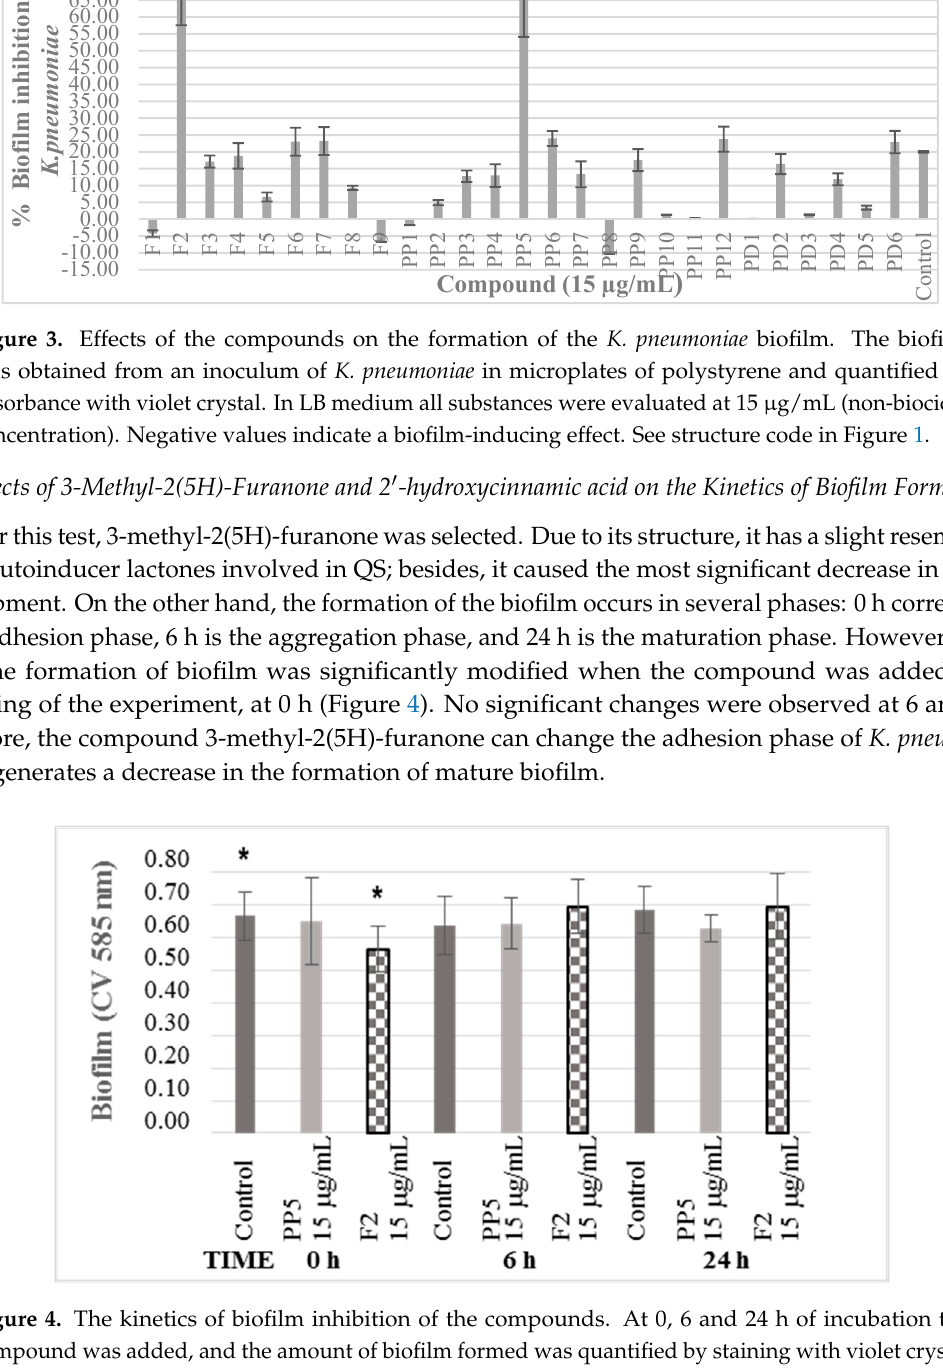
5 2.12. Statistical Analysis Stratigraphic Centurion software (16.2.04) (The Plains, VA, USA) was used to establish a comparison in means of the assays with a confidence level of 95%. 3. Results 3.1. Effects of Compounds on the K. pneumoniae Viability Nearly all compounds showed viability of >85% at all assayed concentrations, including the lowest 25 µg/mL concentration, except 4´-hydroxyphenylacetic (PP6) and 3,4-dihydroxybenzoic acid (PP12) (Figure 2). Therefore, a lower level for the other experiments was selected (15 µg/mL) to avoid possible biocidal effects that could modify the results. Figure 2. The effects of the compounds evaluated on the viability of K. pneumoniae . Minimum viability 85% growth was established respect to the found in the control medium without substances. See structure code in Figure 1. 3.2. Effects of the Substances on the Formation of Biofilm of K. pneumoniae